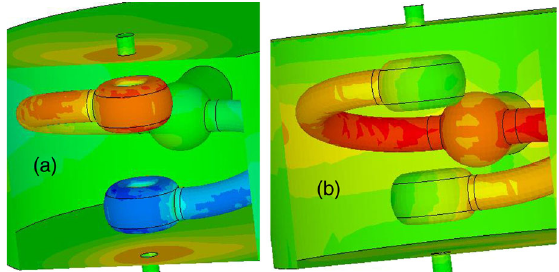
FIG. 2. Low frequency phase detecting mode for distributions of E -field (a) and H -field (b) in